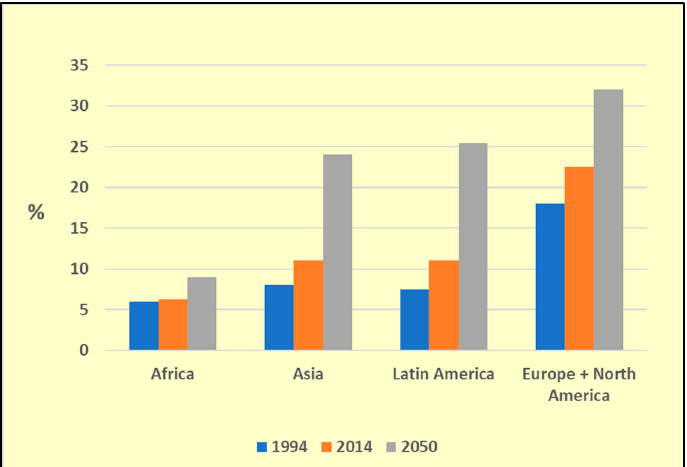
Figure 2. Percentage of population aged 60 years or older for major areas for the years 1994, 2014 and 2050 [3].